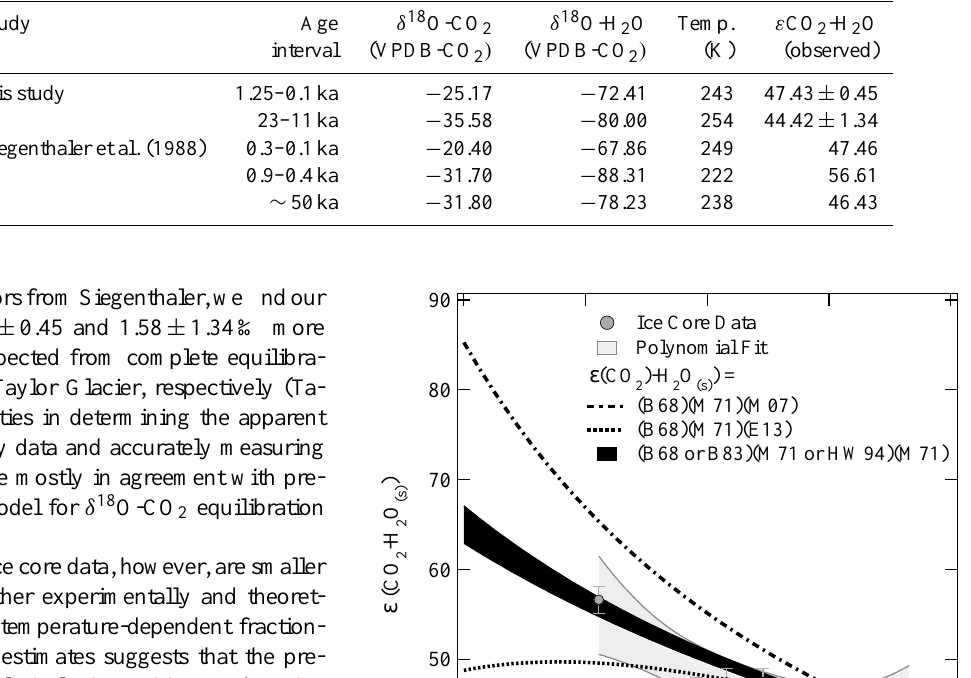
Table 3. Observed δ 18 O of CO 2 fractionation results from this study and other studies.